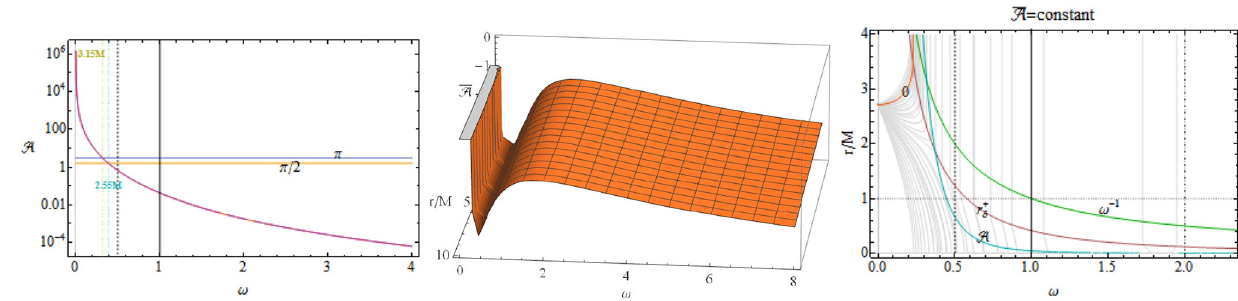
Fig. 32 The areas A of the regions of the extended plane π a bounded frequency ω and radius r / M . The role of the frequencies ω = 2 and ω = 0 . 5 is indicated. Right panel: curves A = constant as functions of by a ± ω ofFig.8.Theareas A , ¯ A and A r ± = π/ 2oftheregionboundedby the horizons r ± in π + a -region a ≥ > 0- A + r thefrequency ω andradius r / M .The curves A = 0 are redcolored. The are defined in Eq. (B2). Left ± panel: area A as a function of the frequency ω . The areas A r ± and 2 A r ± area A , radius r + ∂ and ω − 1 are also plotted. Negative areas correspond to solutions a < 0. See also Fig. 9 for a 3 D representation of these are also shown. Frequencies corresponding to solutions A r ± = A and 2 A r ± = A are pointed with vertical lines. The corresponding geome- tries ( a = M /ω) are shown. Center panel: area A as a function of the